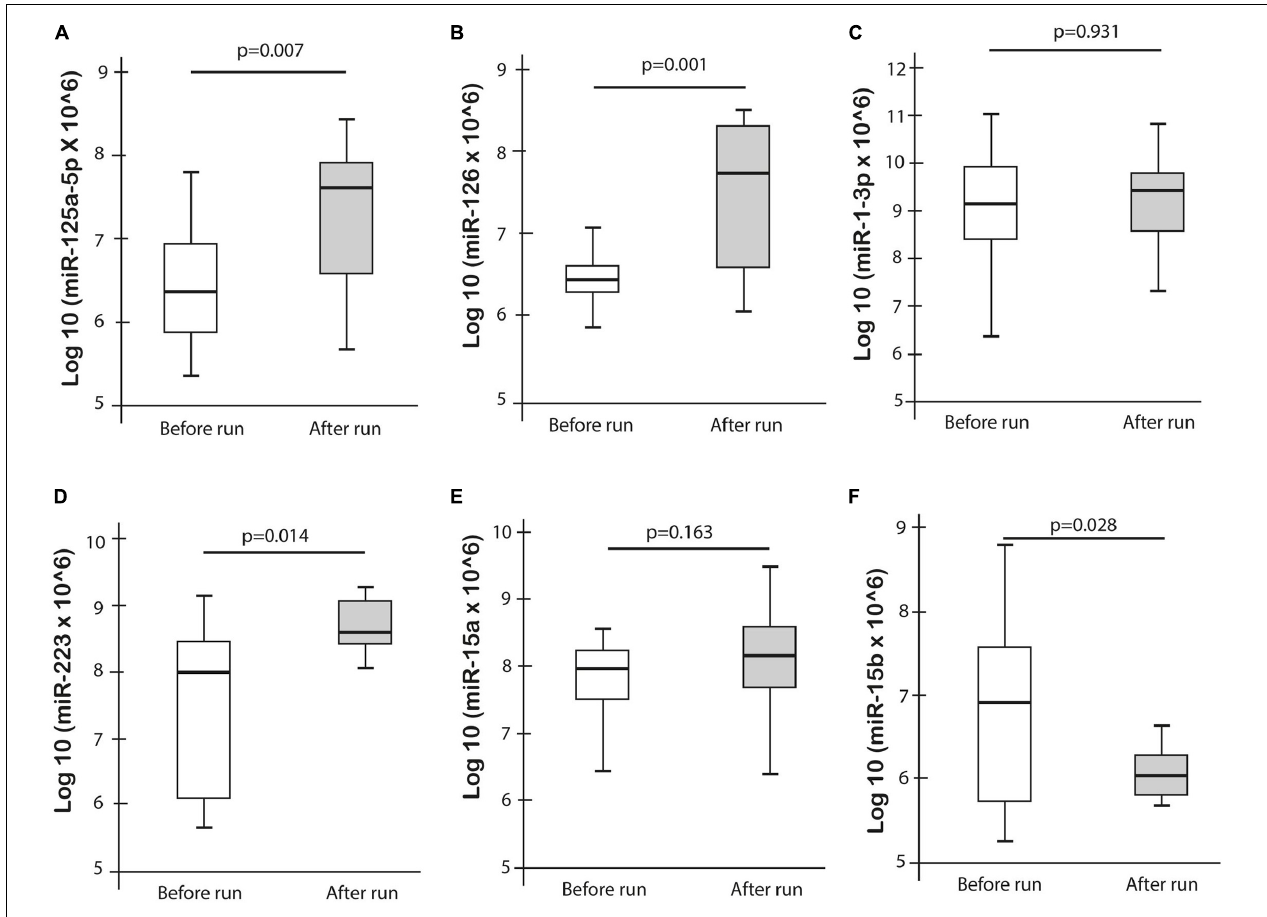
FIGURE 3 | Differences in miRNA expression pre- and